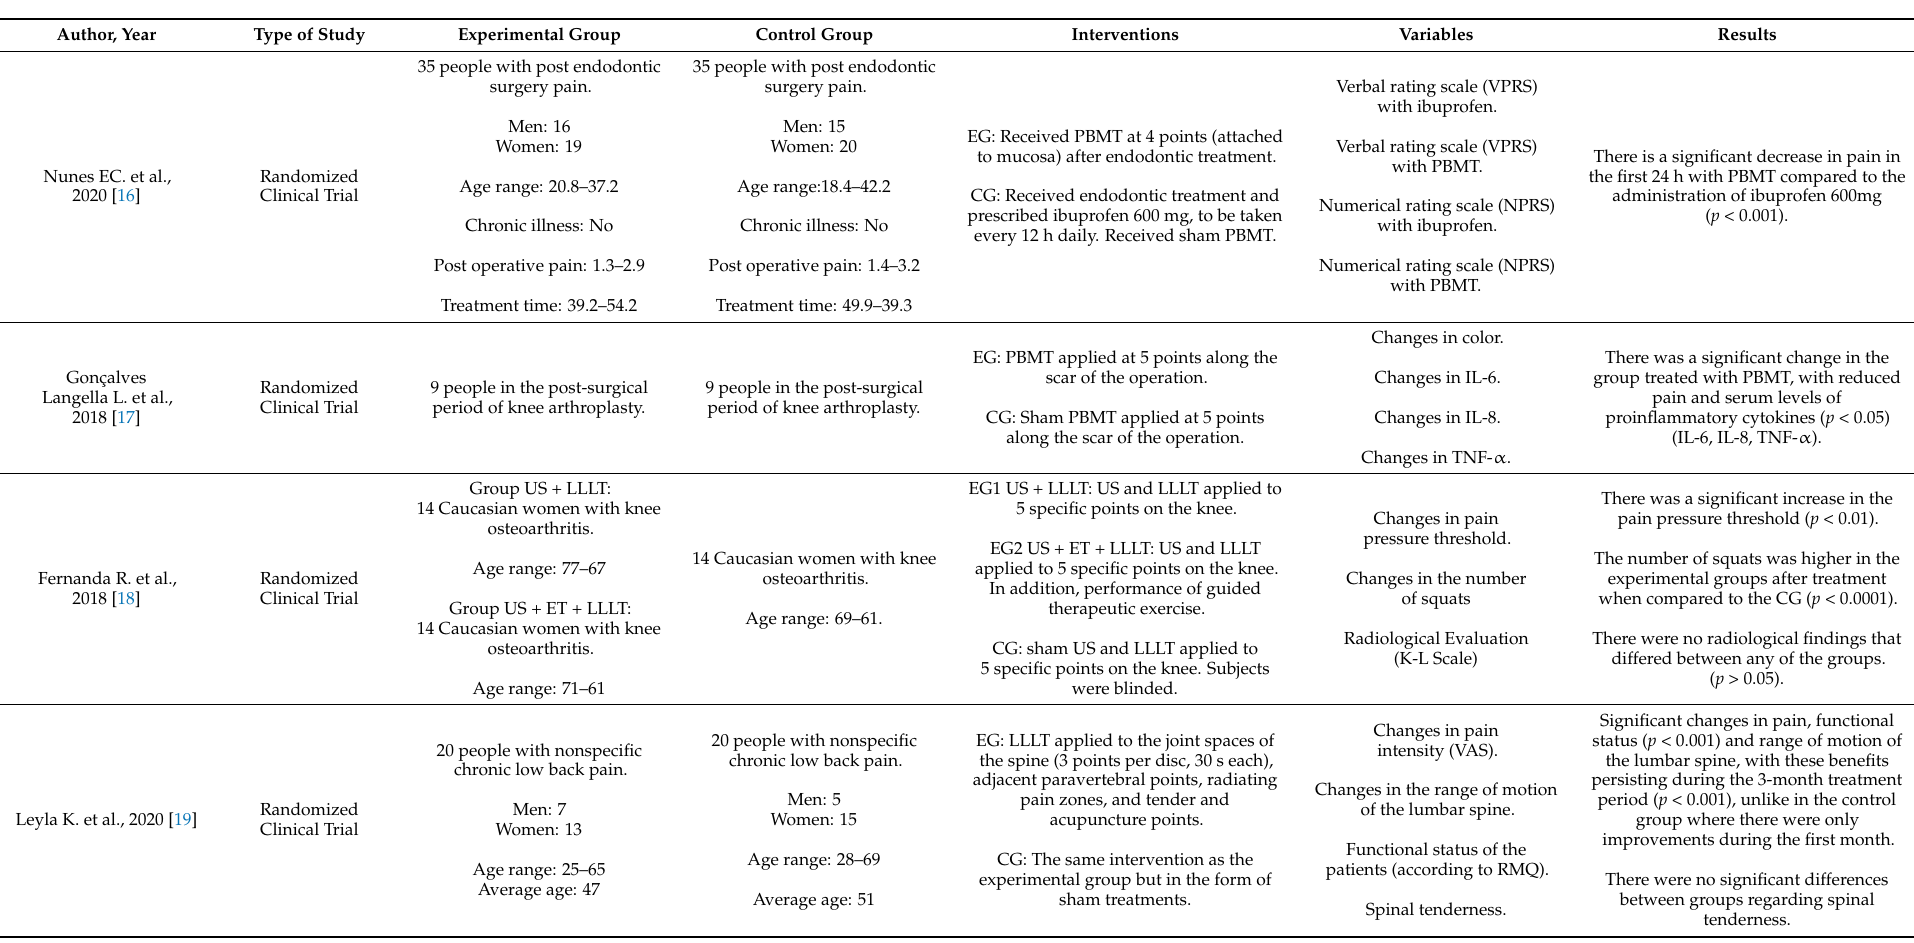
Table 4. Development of the general characteristics for the selected